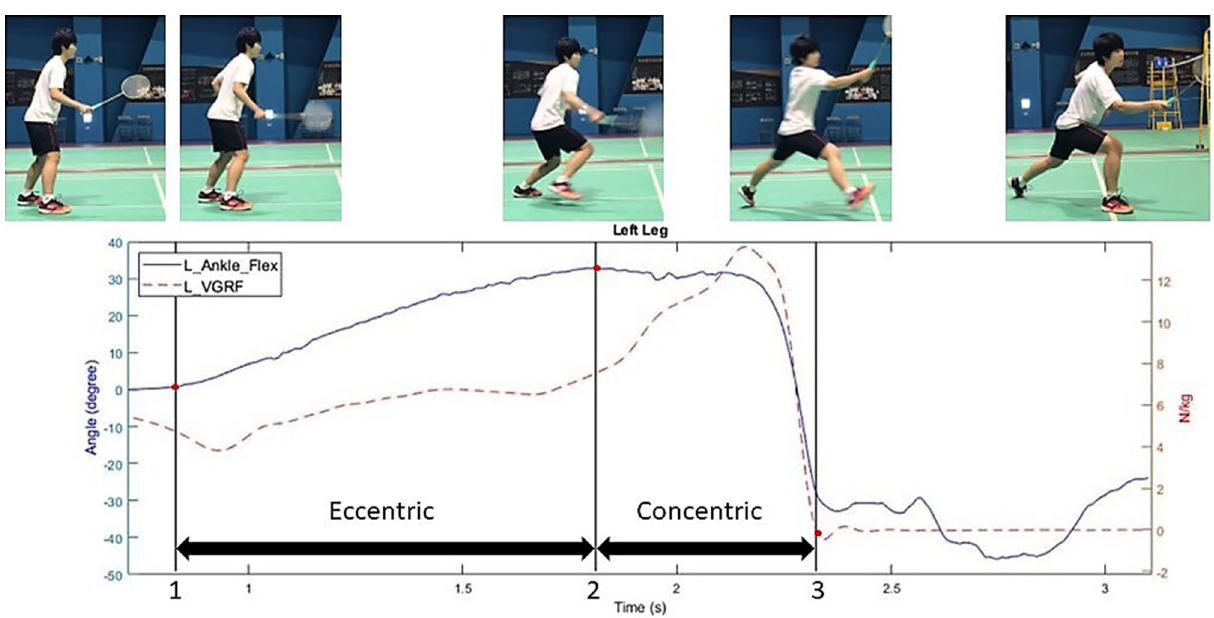
Figure 7. Data segmentation in lunge